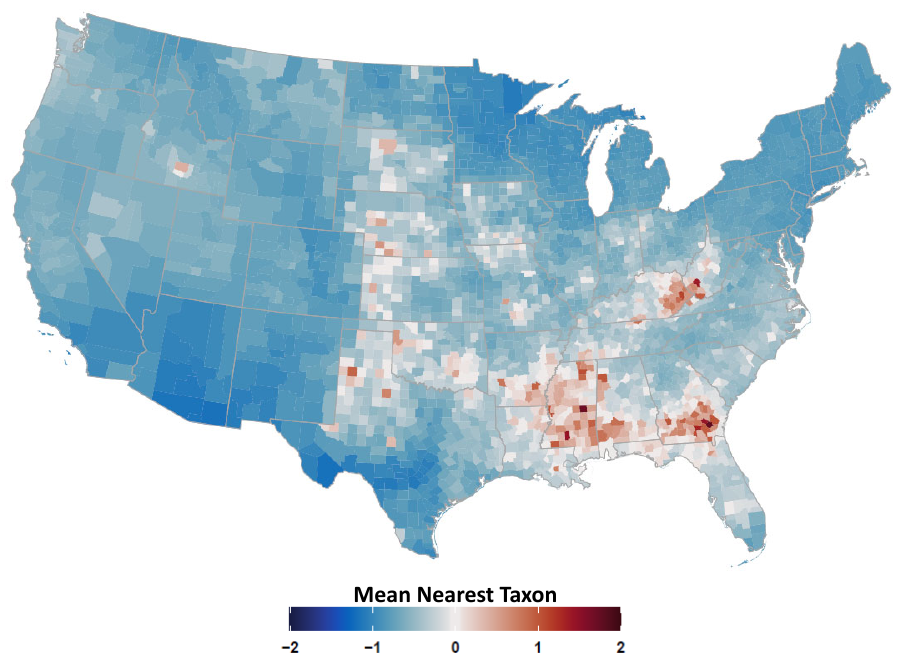
Figure A9. Static avian mean nearest taxon distance. Mean nearest taxon covariate under assumption of a static species pool (May–August). Covariate reflects average genetic distance between nearest neighbors (sister species) within a community. Mapped values have been centered to highlight locations subject to relative phylogenetic clustering (higher than expected relatedness, blue colors) and dispersion (lower than expected relatedness, red